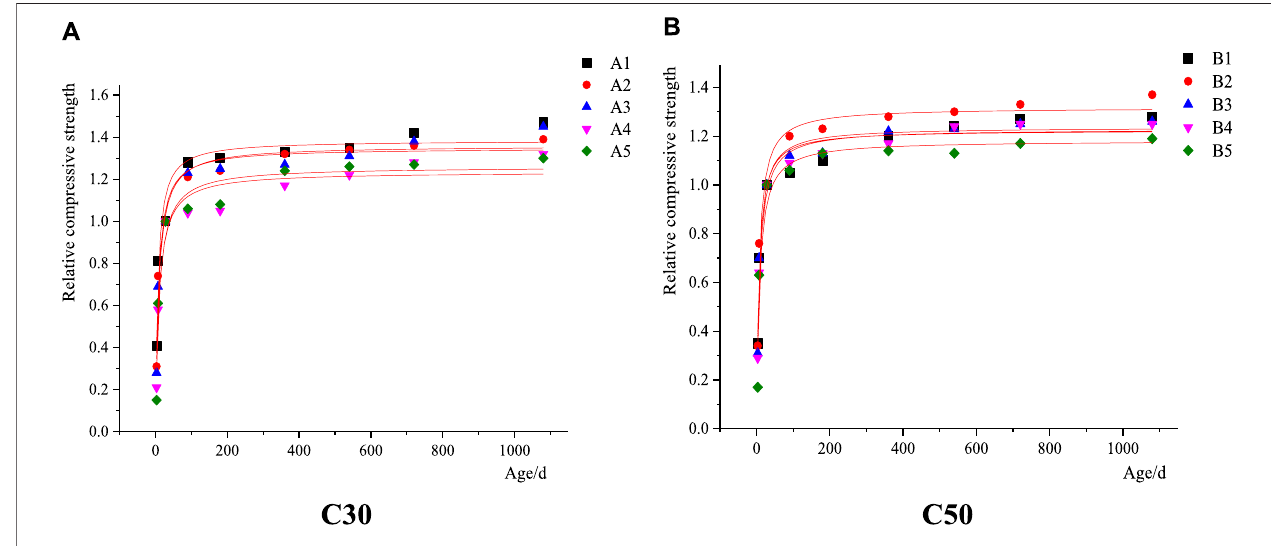
FIGURE 3 | The relative compressive strength and age fi tting curve